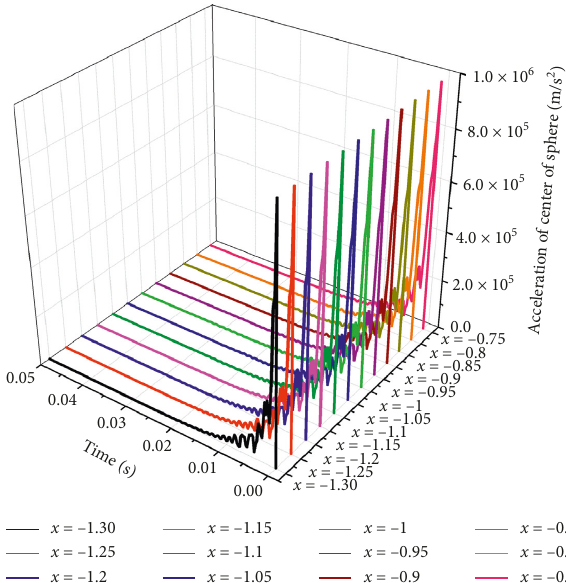
Figure 27: Acceleration of the sphere.